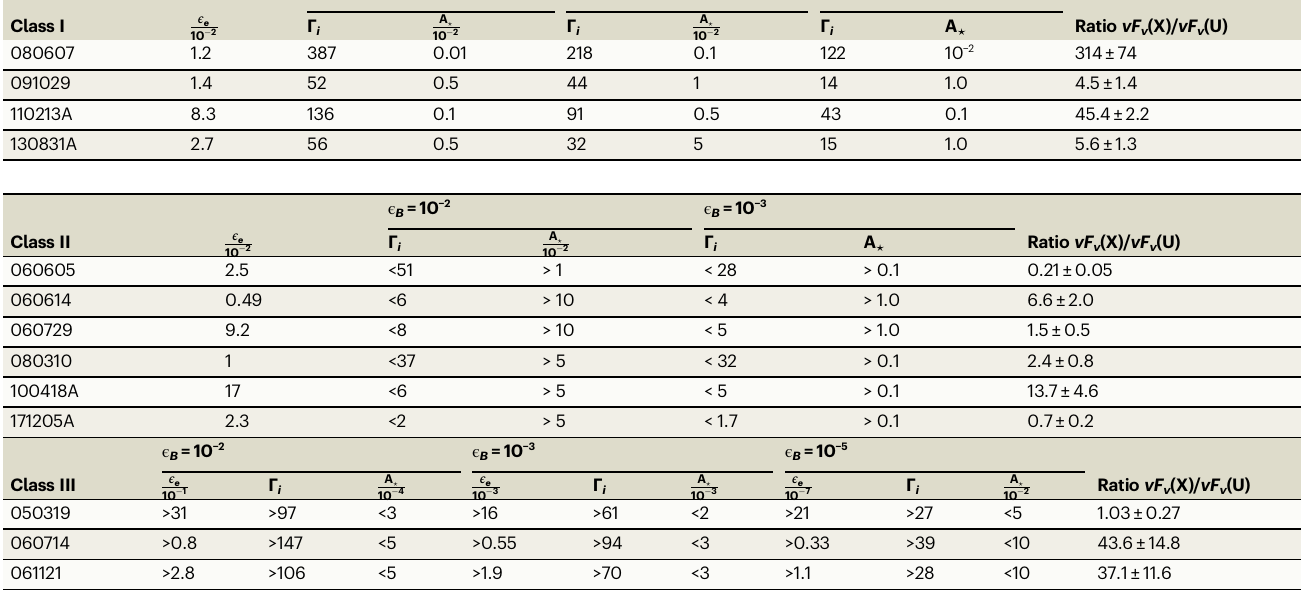
Table 3 | Model parameters of the out fl ow and wind